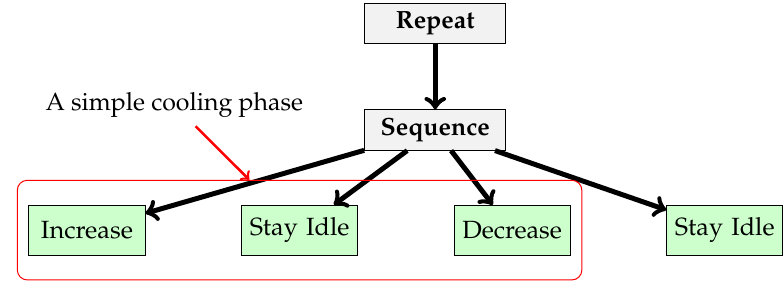
Figure 8. Behavior trees that manage refrigerator